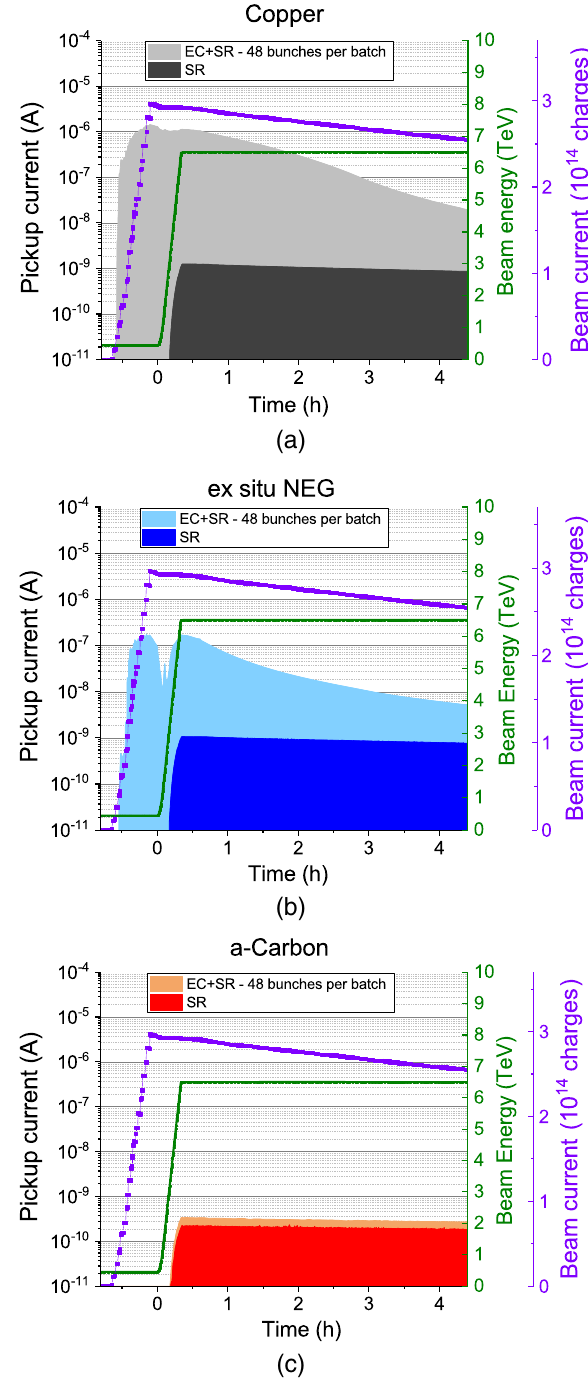
FIG. 13. EC dynamic along a standard 48 bunches per batch fill, comparing the total EC buildup with the contribution of photoelectrons for Cu (a), ex situ NEG (b) and a-C coating